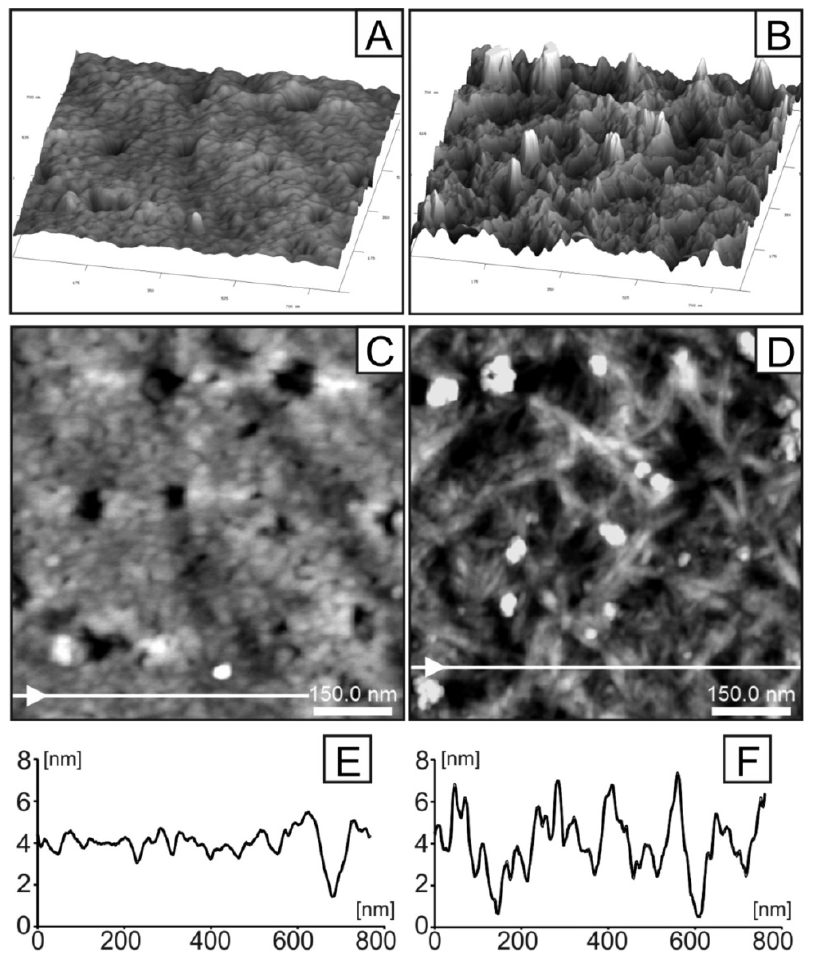
Figure 8. AFM (atomic force microscopy) images ( A – D ) and cross-sectional profiles measured along the white lines shown in Panels C and D ( E , F ) of GLU layer prepared at different temperatures: 80 °C ( A , C , E ) and 90 °C ( B , D , F ). Scanning area: ( A – D ) 780 × 780 nm 2 . Arrows on the white lines shown in Panels C and D define scan direction.